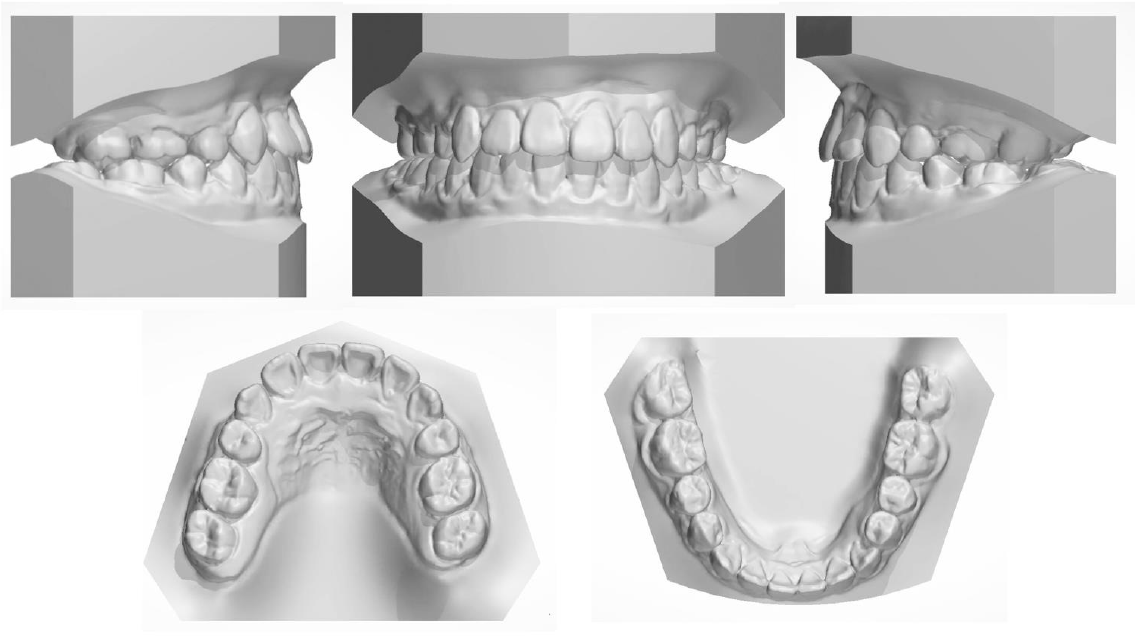
Figure 8. Posttreatment dental casts.